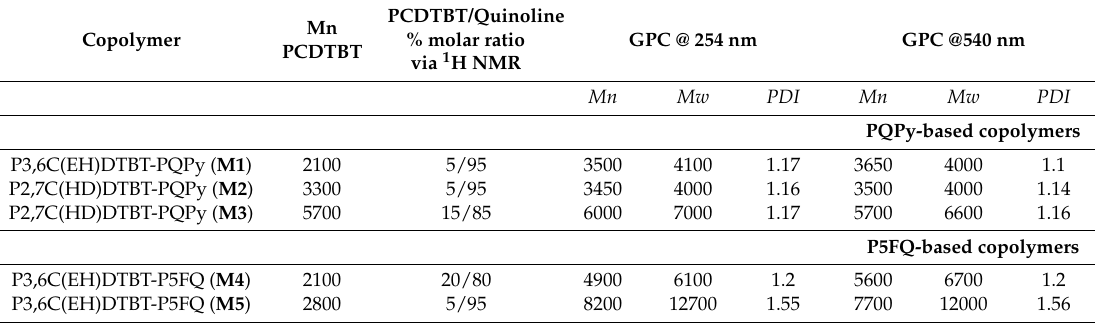
Table 2. Feed ratio and GPC results for the copolymers P3,6C(EH)DTBT-PQPy P2,7C(HD)DTBT-PQPy and P3,6C(EH)DTBT-P5FQ at 254 and 540